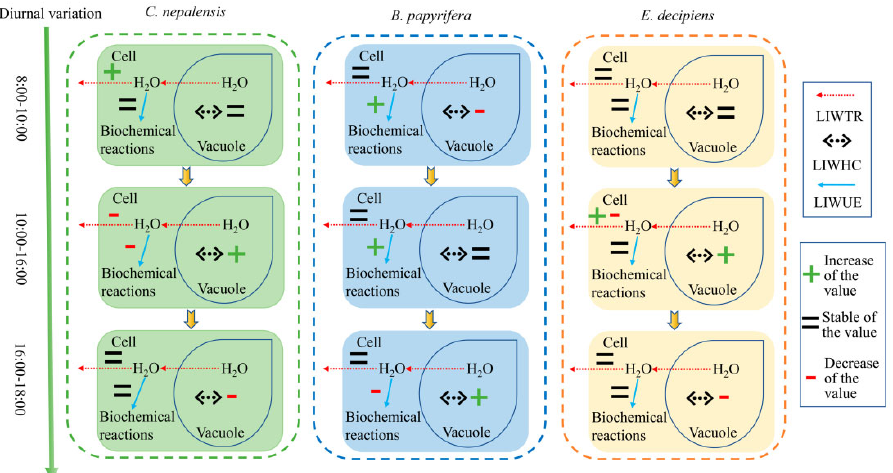
Figure 4. Dynamic traits of leaf intracellular water in C. nepalensis, B. papyrifera , and E. decipiens . LIWTR, leaf intracellular water transport rate; LIWHC, leaf intracellular water-holding capacity; LIWUE, leaf intracellular water-use efficiency.